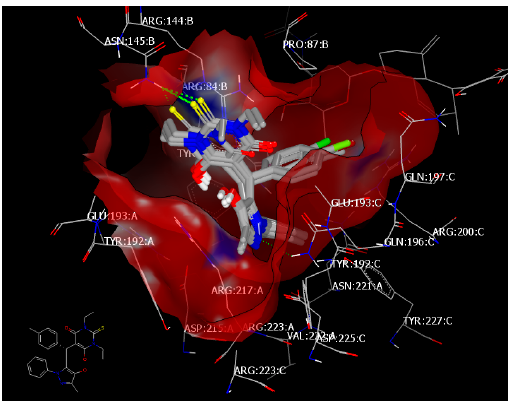
Figure 8. Visual representation of compound 4d docked with 4URM and overlay with 4c , 4a and 4f . The compounds showed hydrogen bonding between the sulfur of the pyrimidine ring and ASN 145:A, as shown by Vida.